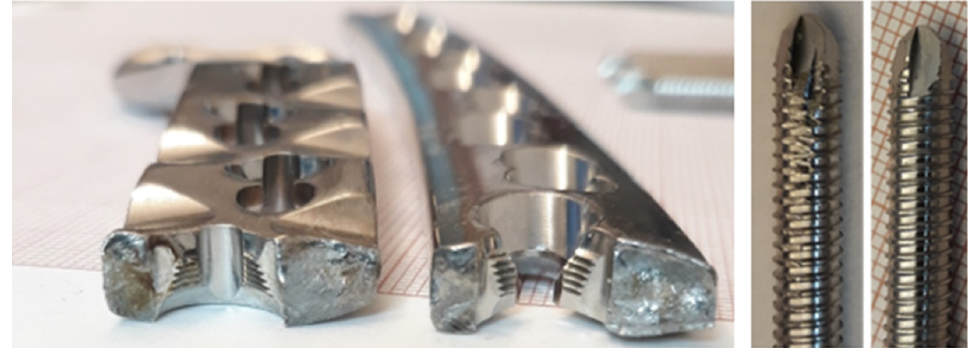
Figure 14. Visual inspection of the fracture surface of the steel implant compared to the as-received and exploited screw.